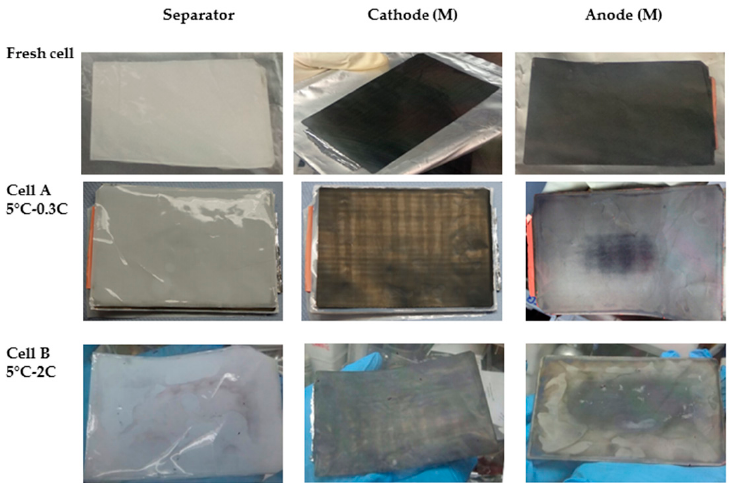
Figure 2. Visual inspection of cells components (separator, cathode and anode from the middle (M) of the stack).